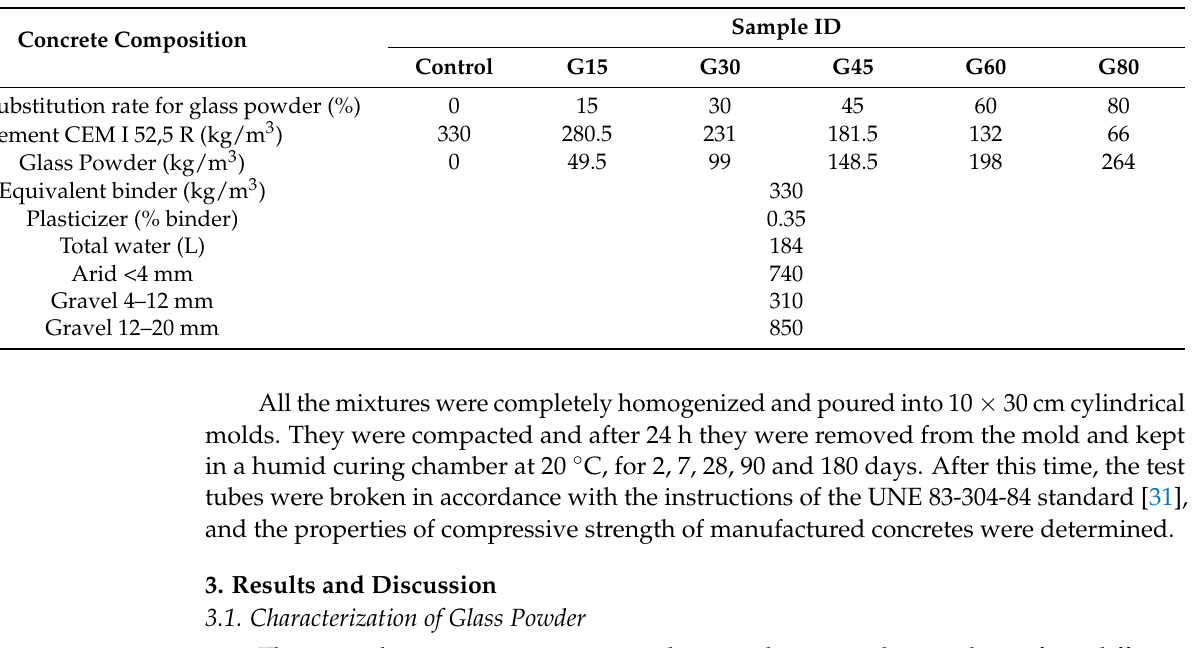
Table 1. Summary of experimental conditions for the samples